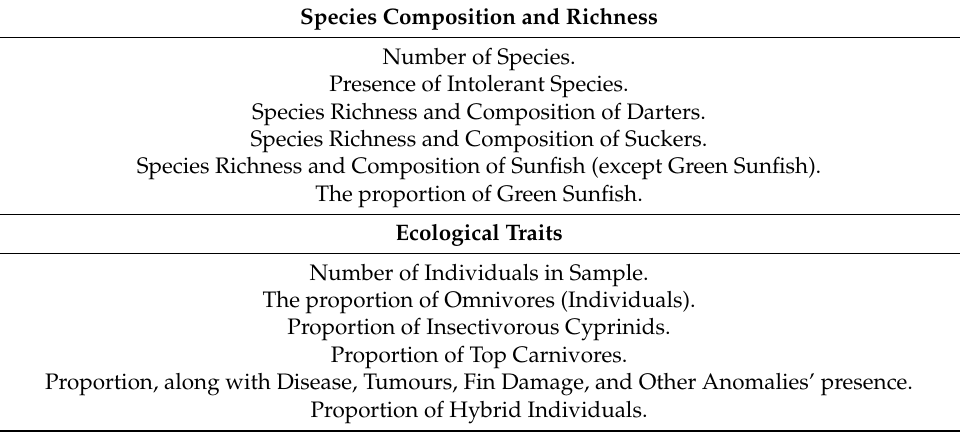
Table 1. List of parameters and ecological traits used in the assessment of fish communities; modified from [31].